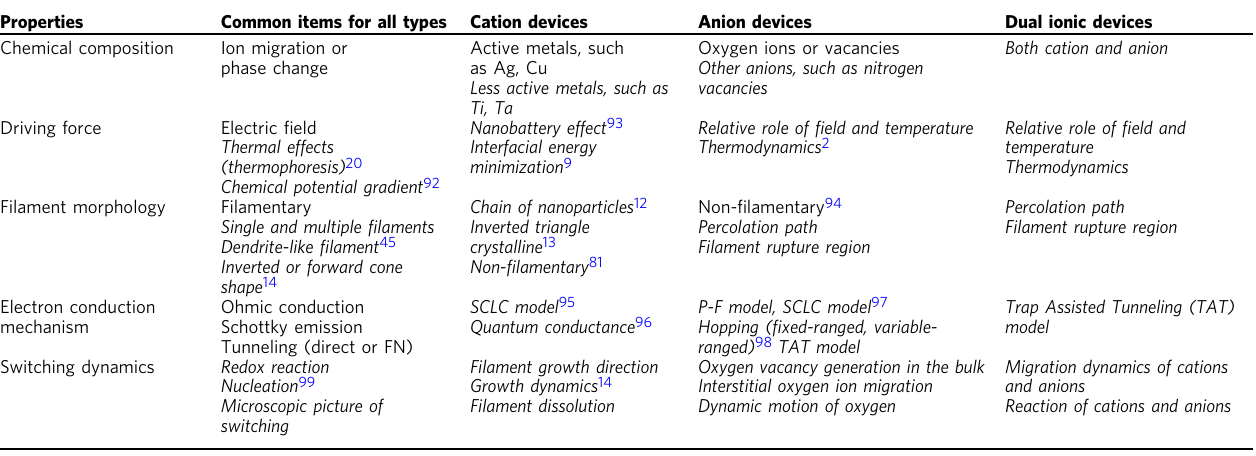
Non-italicized indicates the conclusive fi ndings, and italicized represents arguments not fully conclusive